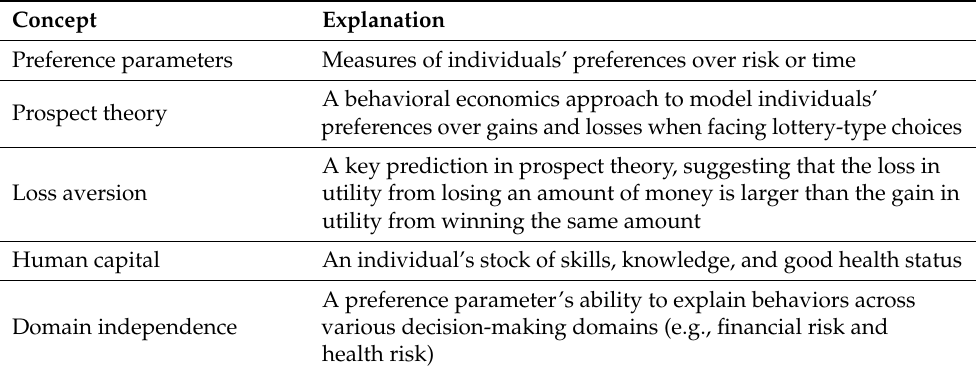
Table 1. Glossary of behavioral economics concepts used in this